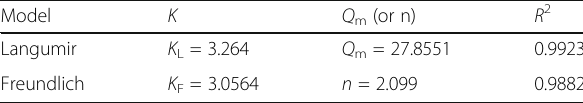
Table 2 The relevant parameters of the two models Model